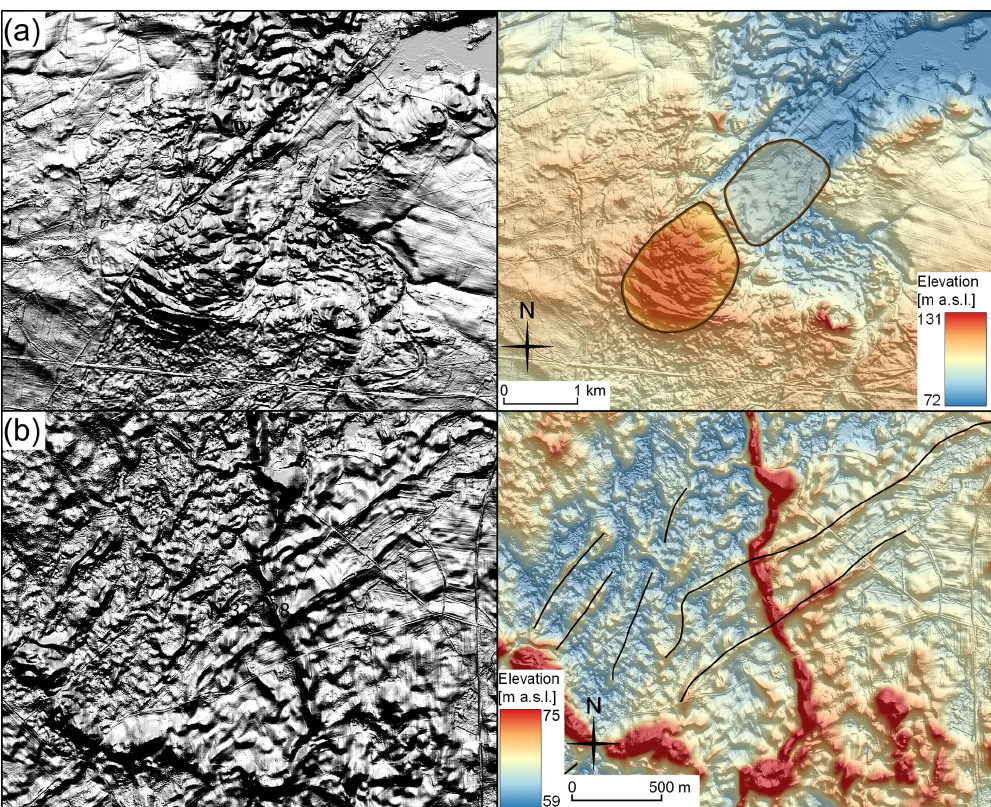
Figure 8. Examples of (a) hill–hole-pair and (b) geometrical ridge network, as plain hillshade model (left) and DEM superimposed on hillshade model